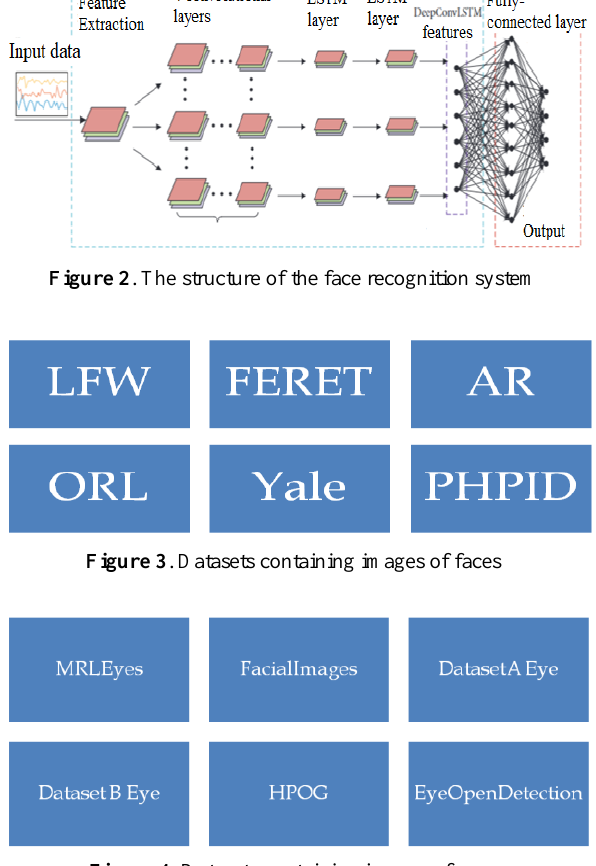
Figure 4 . Datasets containing images of